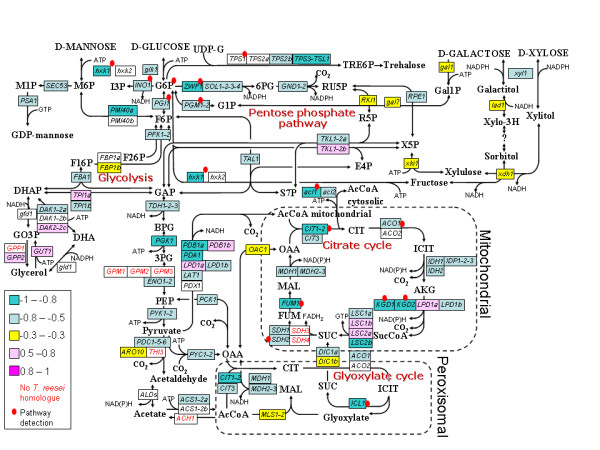
Correlations of genes in central carbon metabolism with SPPR. Metabolic network of metabolites and genes (rectangles). Genes are colored according to correlation to SPPR. Gene names are as in S. cerevisiae, except that paralogs not found in yeast are distinguished by additional letters (a,b,...) and genes corresponding to many genes in S. cerevisiae have names extended with '-'. T. reesei gene names have been used when available (hxk1, glk1 [65], lxr1 [126], xdh1 [127], xyl1 [128], lad1 [129], gld1, gfd1 [61], gal10, gal7 [130], xdh1 [127] ) and others when T. reesei nor S. cerevisiae name exists (acl1, acl2 [93]). Cellular locations are merely indicative. Genes detected by pathway detection are specified with a red dot.